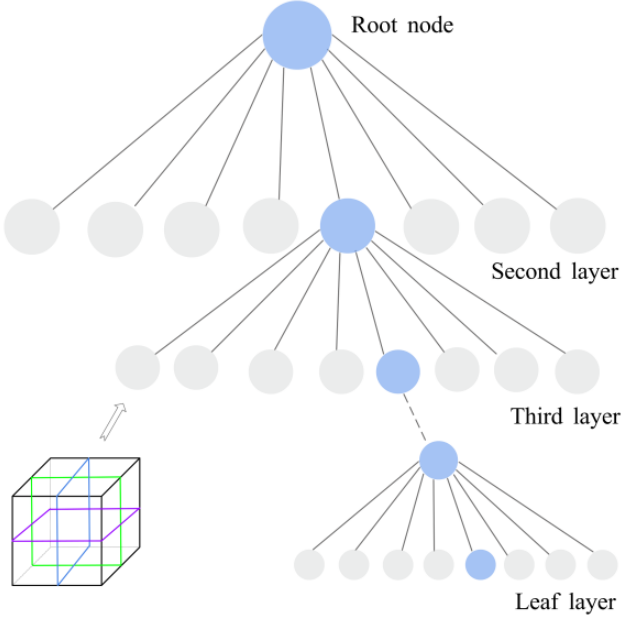
Figure 13. Principle of octree compression.